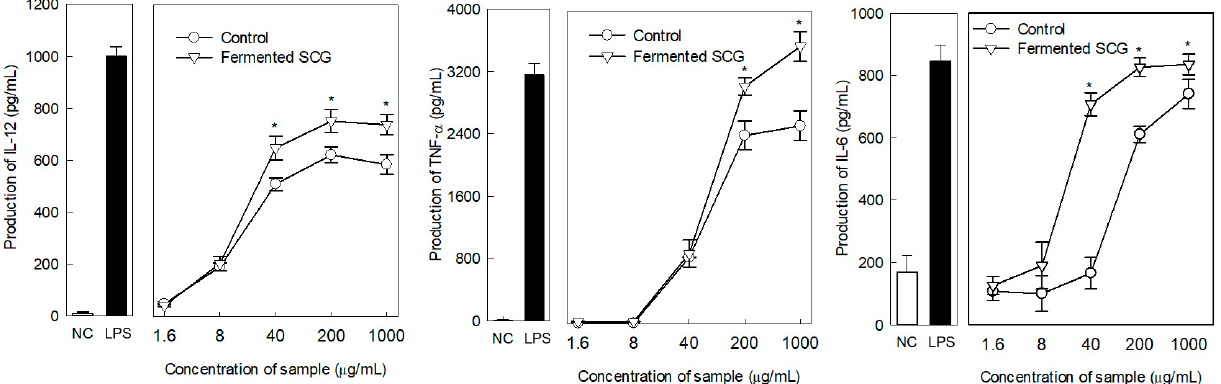
Figure 3. IL-12, TNF- α , and IL-6 production by murine peritoneal macrophages induced by the fermented SCG. Medium was used as the negative control (NC). Lipopolysaccharide (LPS; 5 µ g/mL) was used as the positive control. The differences between the unfermented control and fermented SCG were evaluated using Student’s t -test (* p < 0.05).